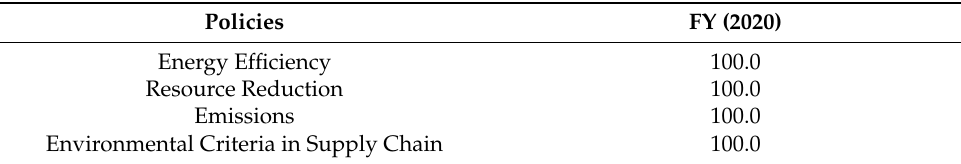
Table 2. The share of companies implementing environment-related